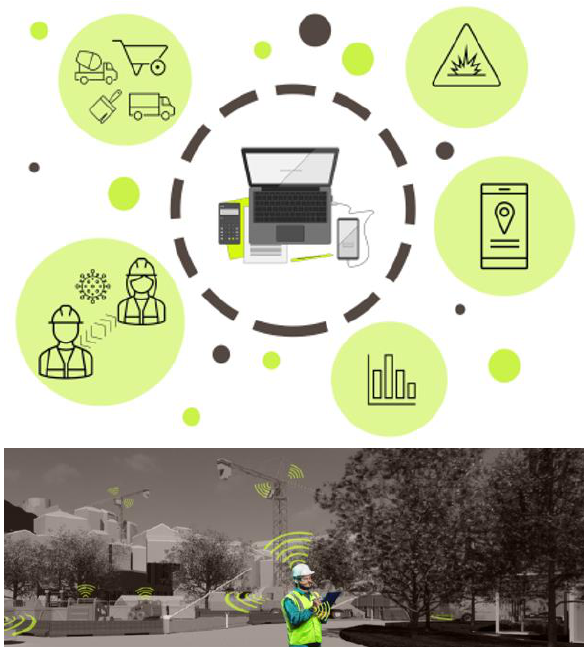
Figure 5: Example of connection of the CoFlex system with other sensor systems for site control and